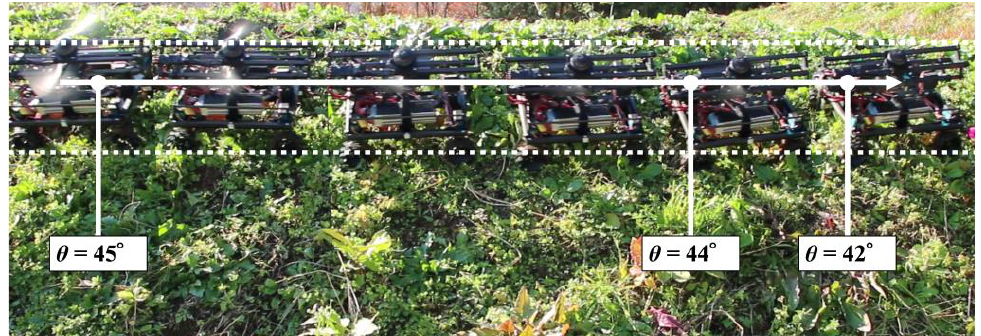
Figure 13. Straight movement experiment on grassy terrain in a mountainous area.